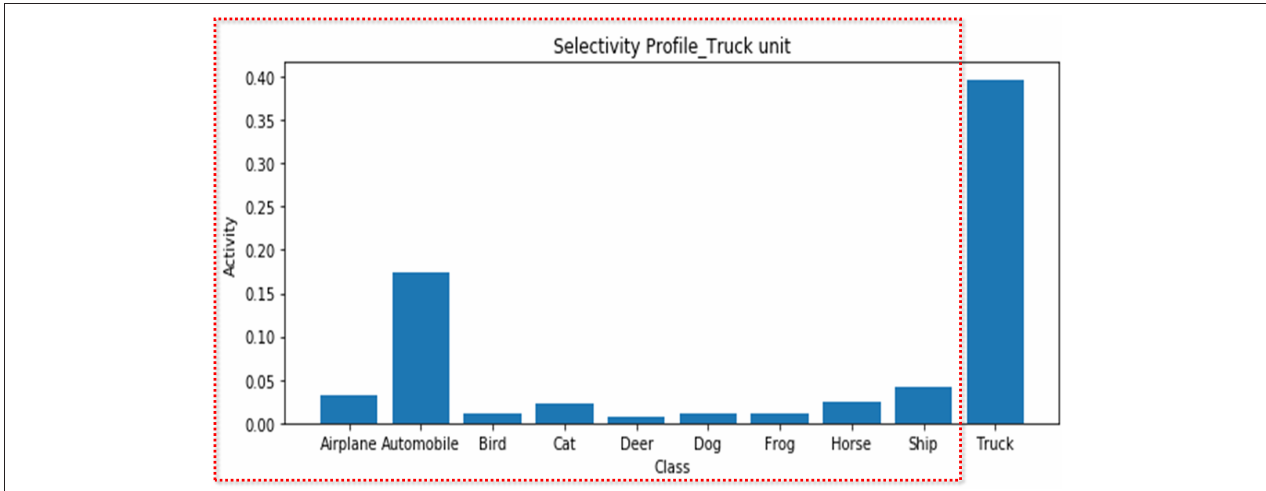
FIGURE 2 | Selectivity profile of the truck unit. The average activities of the truck unit for each stimulus feature are presented. Although the truck unit is a population of neurons tuned to the truck feature, if only the features in the red dotted box are presented, the suboptimal feature (automobile) may appear to be the variable that best accounts for the unit’s activity.